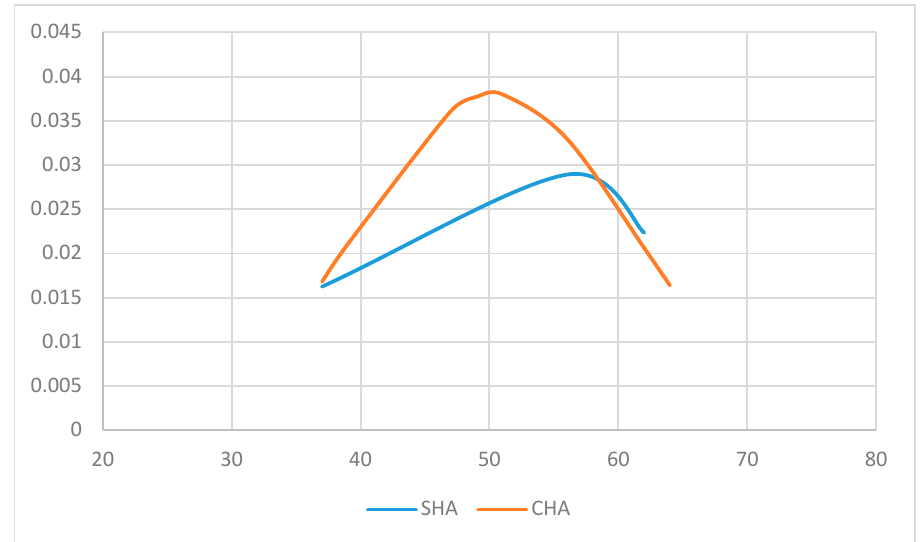
Figure 7. Simple (SHA) and complex (CHA) endometrial hyperplasia with atypia histopathologic diagnosis distribution, according to patient age